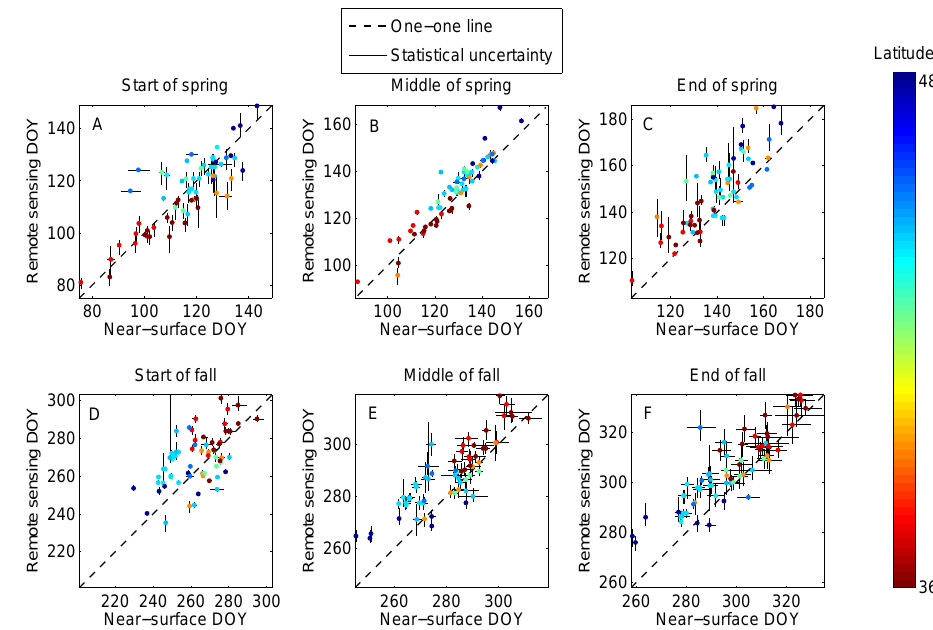
Figure 5. Scatterplots of the comparison between near-surface GCC analysis and remote sensing of NBAR-EVI using the generalized sigmoid